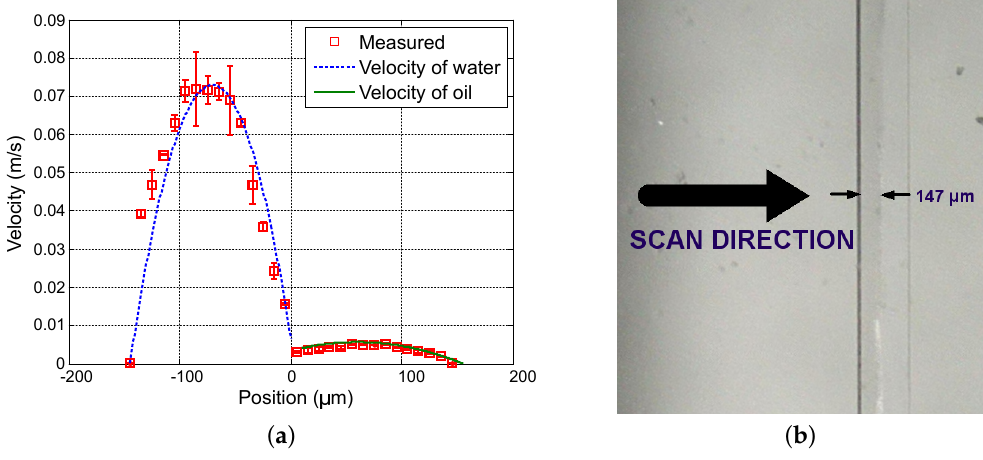
Figure 5. Experimental results for Q water = 35 µL · min − 1 and Q oil = 3 µL · min − 1 . ( a ) Measured profile (squares) and theoretical profile for water (dashed line) and for oil (solid line); and ( b ) reference image of the main channel with indication of the interface